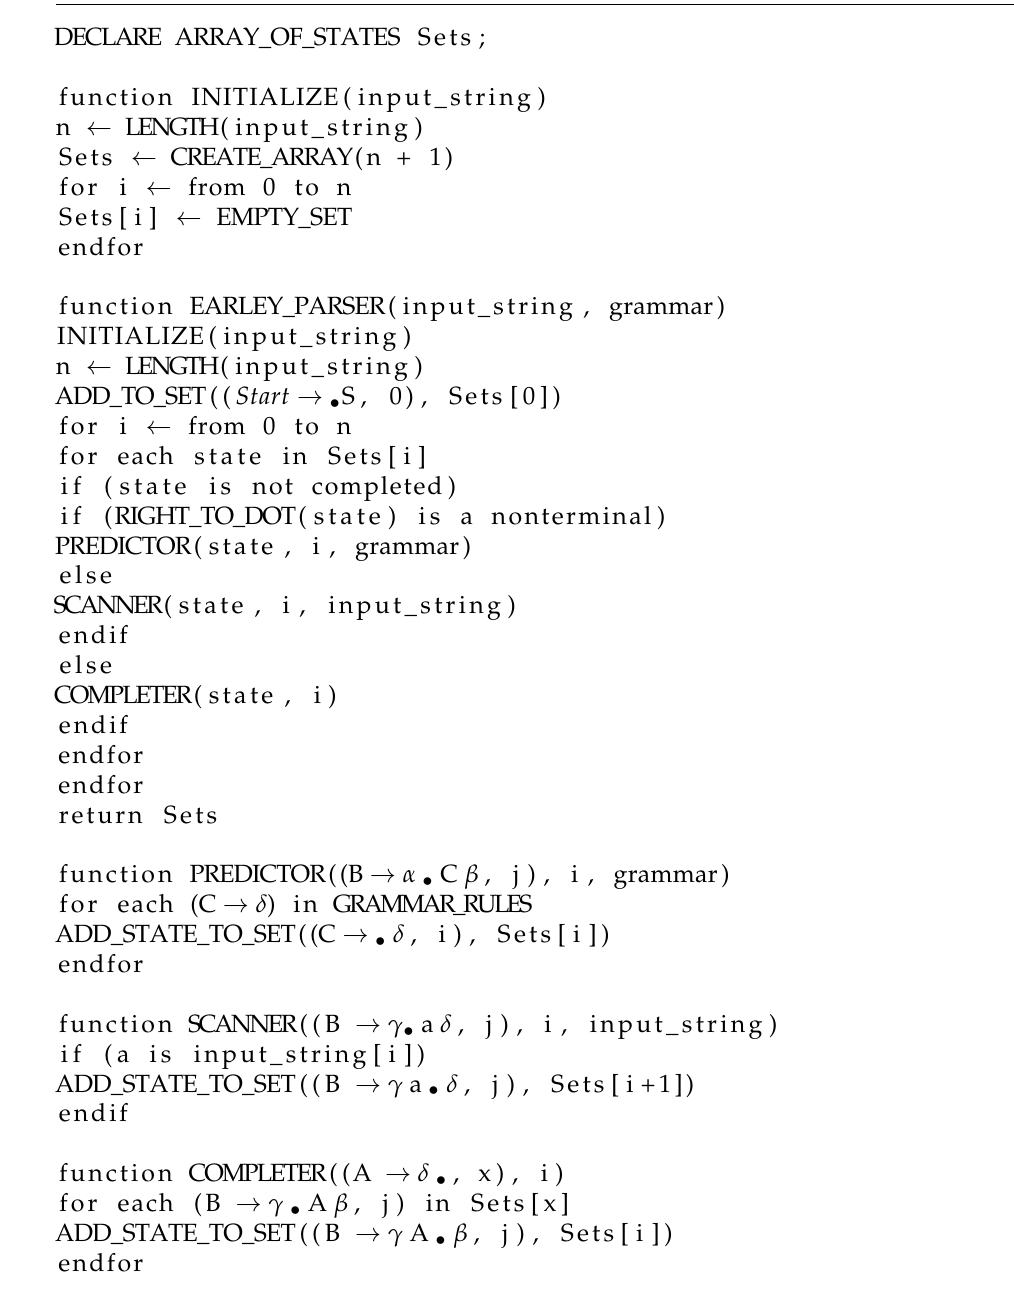
Algorithm 1 Earley’s Parser